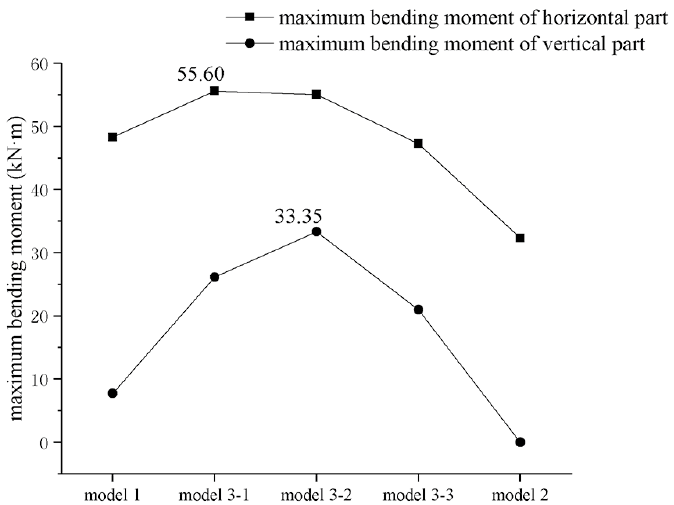
Figure 18. Maximum bending moments of the horizontal part and vertical part for the bH-shaped components in each model.